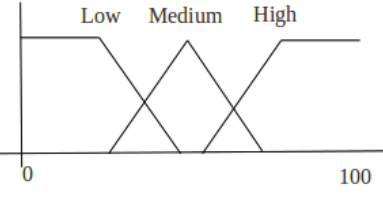
Fig. 1. Fuzzy domains for variables X 1 and X 2